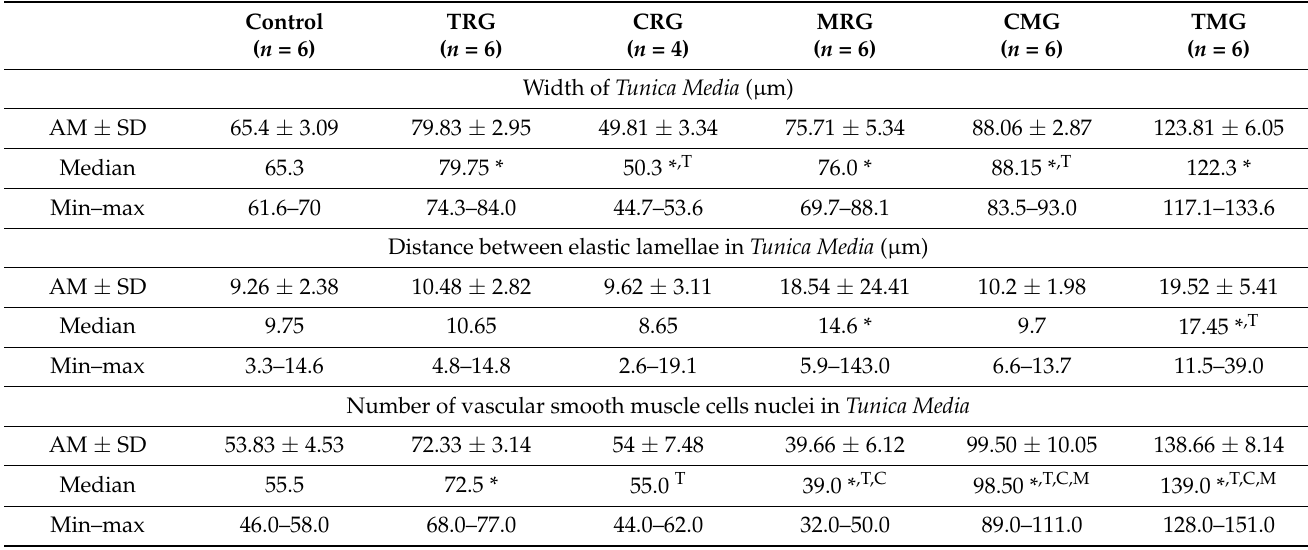
Table 1. The parameters of morphometry of the aorta of rat treated with different immunosuppressive drugs protocols.